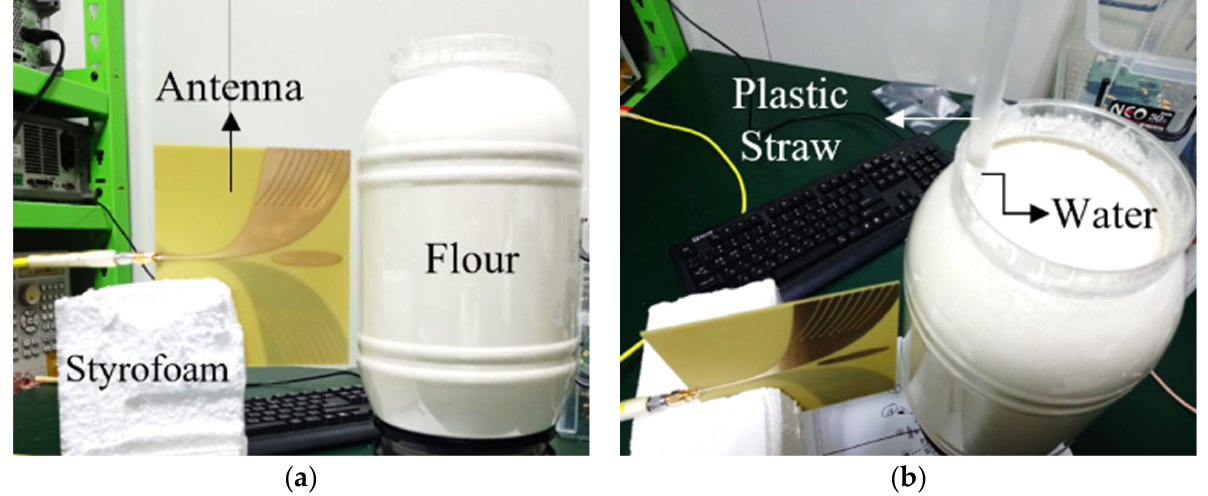
Figure 12. Measurement setup: ( a ) Side view where the antenna is mounted in a block of Styrofoam. ( b ) A plastic straw of 1 cm diameter filled with mineral water (cid:4666)𝜀 (cid:3047) (cid:3404) 80 ) is inserted in the back ‐ ground medium which constitutes wheat flour ( 𝜀 𝑏 (cid:3404) 2.5 ).